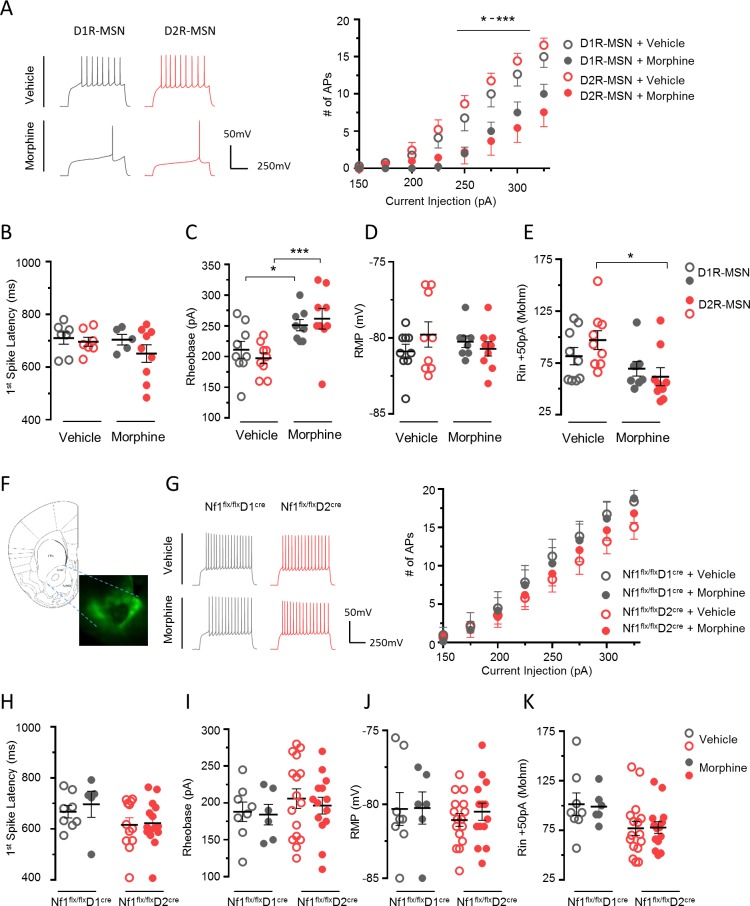
MSNs lacking NF1 are resistant to morphine-induced reduction in excitability.(A) Representative traces at 250-pA injection level and the mean number of APs generated for a given level of current injection in D1R-MSNs and D2R-MSNs following morphine administration. n = 8–9 neurons/group. Comparison of the (B) first spike latency (ms) (C) firing threshold (rheobase), (D) RMP, and (E) input resistance (Rin) in D1R-MSNs and D2R-MSNs of drug-naïve and morphine-treated mice. n = 8–9 neurons/group. (F) Image of the NAc in Nf1flx/flxD2Cre mouse stereotaxically injected with AAV9-Flex-EGFP. (G) Representative traces and the mean number of APs generated for a given level of current injection in Nf1flx/flxD1Cre and Nf1flx/flxD2Cre mice following morphine administration. n = 8–16 neurons/group. Comparison of the (H) first spike latency (ms), (I) firing threshold (rheobase), (J) RMP, and (K) input resistance (Rin). n = 5–16 neurons/group. *P < 0.05, ***P < 0.001, two-way RM ANOVA. Data are represented as mean ± SEM. Underlying data for this figure can be found in S1 Data. AP, action potential; D1R, D1 dopamine receptor; D2R, D2 dopamine receptor; MSN, medium spiny neuron; NAc, nucleus accumbens; NF1, neurofibromin 1; RM-ANOVA, repeated measures analysis of variance; RMP, resting membrane potential.